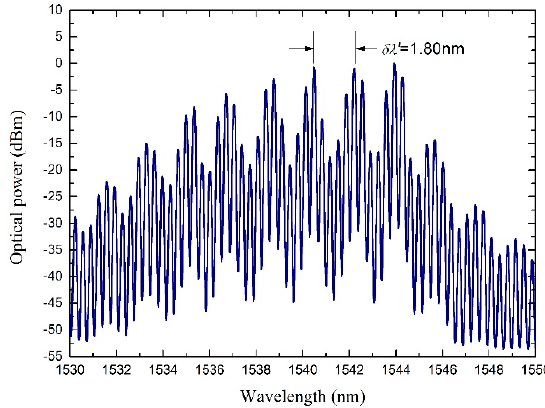
Figure 5. Optical spectrum filtered with a 2.53 m long BOF.